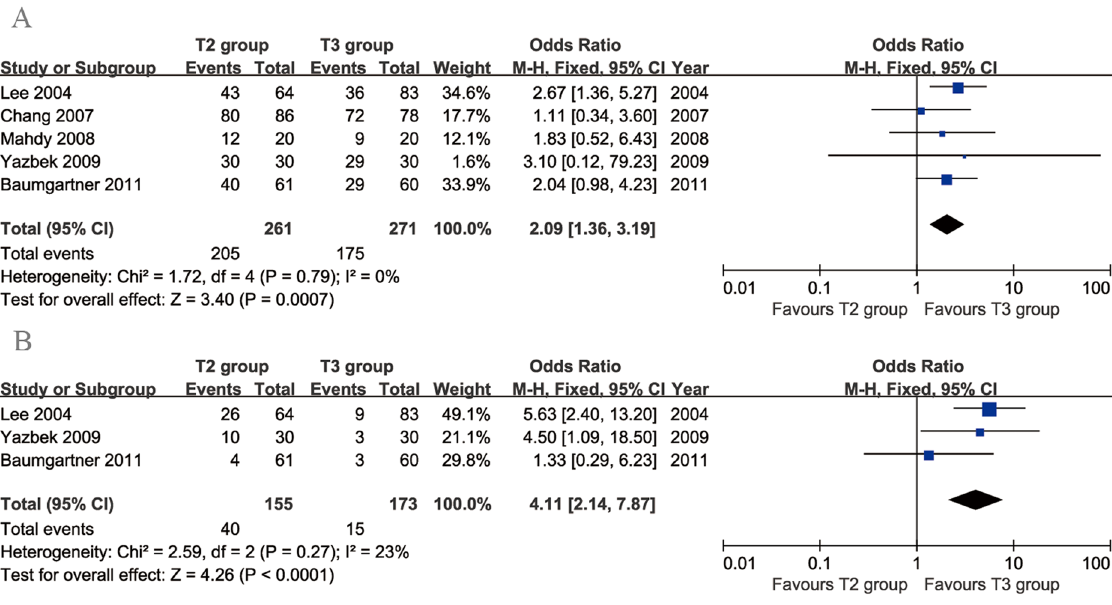
Figure 3. Forest plots for compensatory sweating ( A ) and moderate-to-severe compensatory sweating ( B ) in the T2 and T3